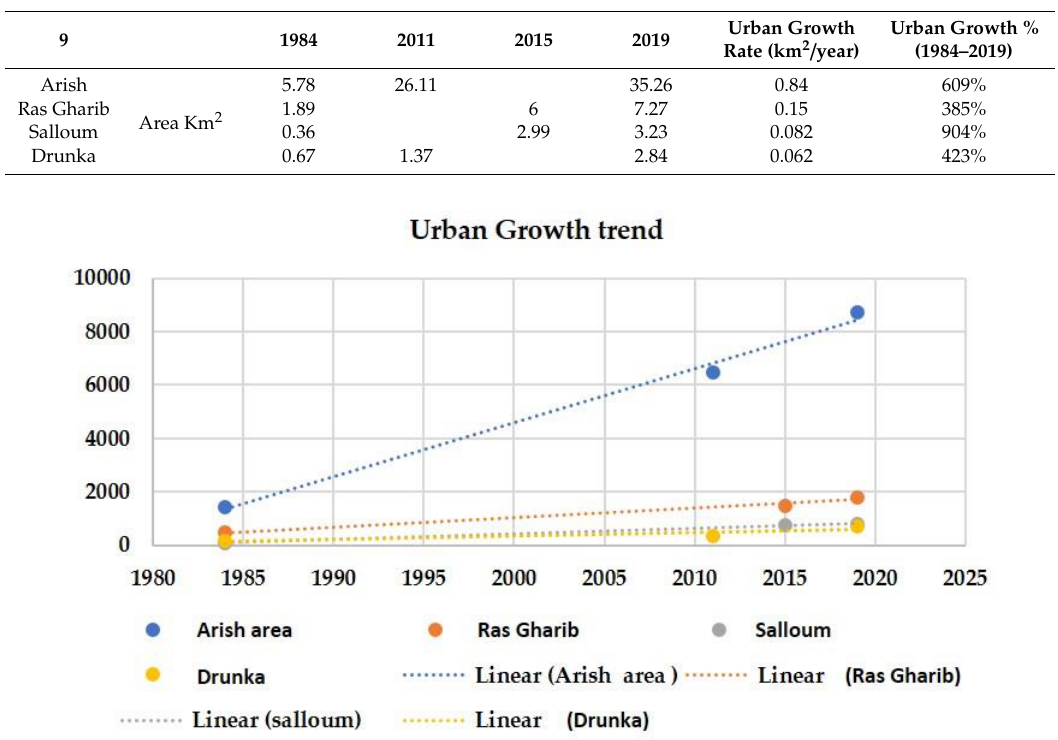
Figure 9. The urban growth changes over the time from 1984 to 2019.